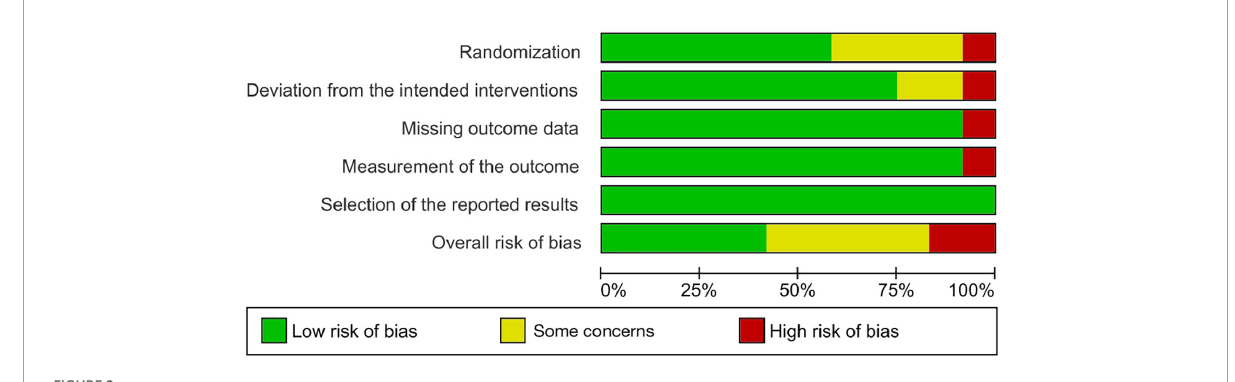
FIGURE2 Risk of bias